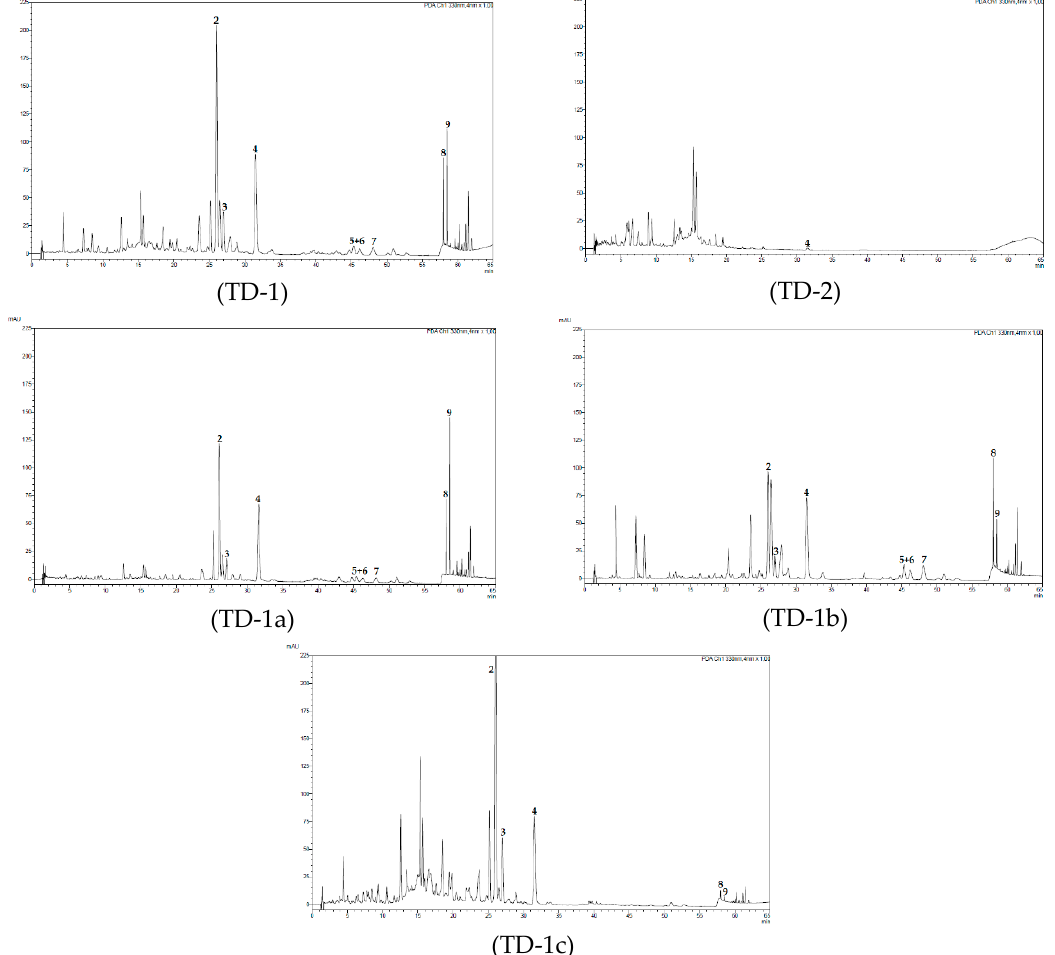
Figure 4. Ultra-high performance liquid chromatography (UHPLC) chromatograms of TD-1, TD-2, and TD-1a to TD-1c.